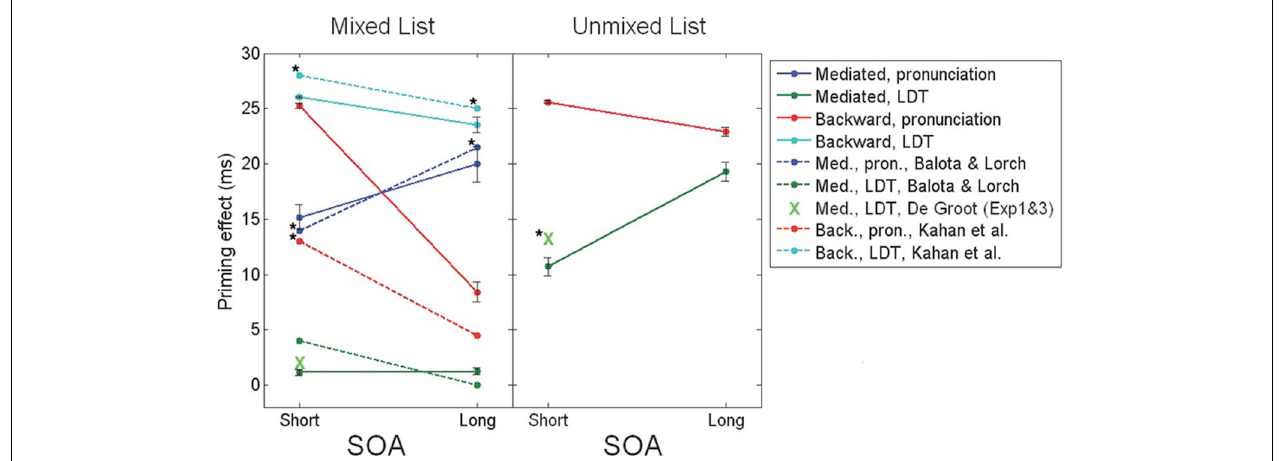
FIGURE 3 | Mediated and backward priming effects in the model (solid lines), alongside corresponding results from human studies (dashed lines, and green X marks). Human results are taken from de Groot (1983),